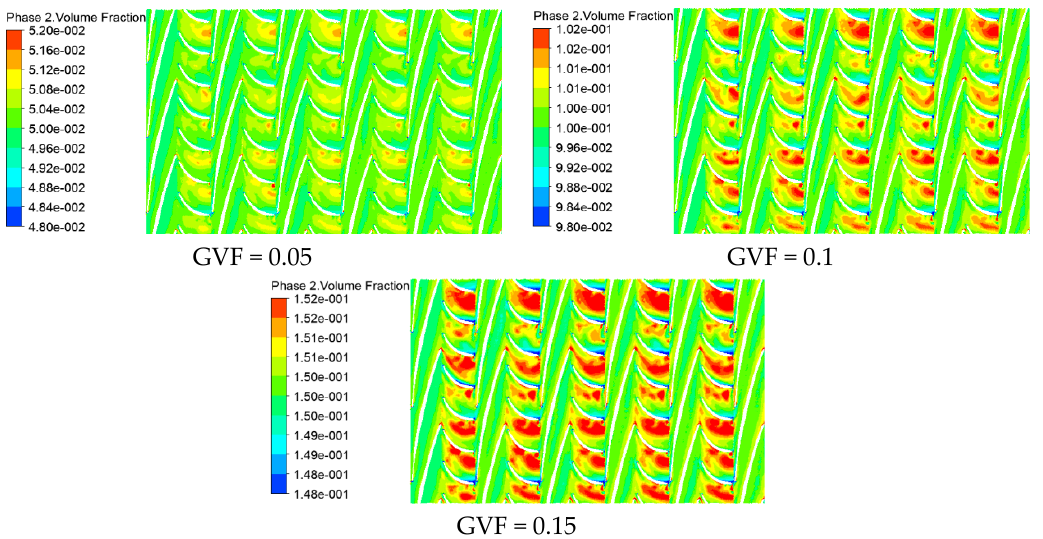
GVF = 0.15 Figure 8. The gas-phase volume distribution in the pressurization unit at 0.5 times the height of the blade at different GVFs. Figure 9 is the nephogram of the gas-phase volume distribution in the pressurization unit at 0.8 times the height of the blade at different GVFs under design conditions, and 0.8 times the height of the blade is the position close to the edge of the impeller. It can be seen from Figure 9 that the maximum gas volume fraction in the impeller gradually increases with the increase in the GVF. However, compared with 0.2 times the blade height and 0.5 times the blade height, the area where the maximum gas volume fraction concentrates with the increase in the GVF is relatively small. It can also be seen that the low GVF region is mainly in the impeller and diffuser at different GVFs, and the low GVF region is mainly concentrated in the dynamic impeller outlet region, near the suction surface of the diffuser blades, and in the bladeless area between the impeller and diffuser. The highest gas volume distribution area is mainly concentrated near the pressure surface of the outlet blade of the diffuser, and it gradually moves towards the inlet of the diffuser with the increase in the GVF. It is also evident that with the increase in the GVF, the low GVF area and the high GVF area in the impeller and the diffuser gradually increase, that is, the gas-liquid separation degree gradually increases, especially in the